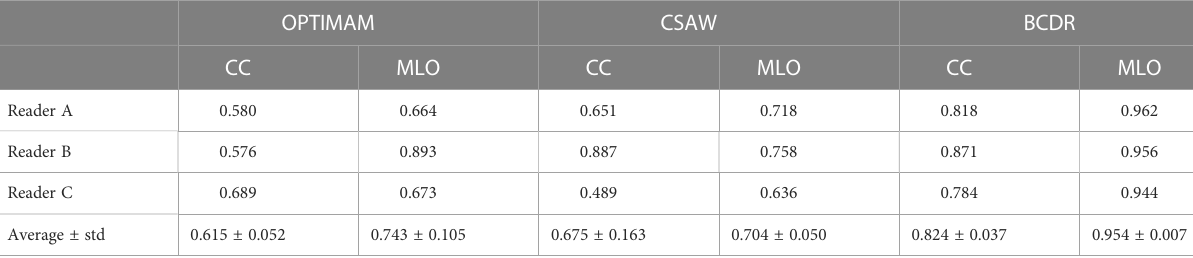
TABLE 5 Reader test results: Area Under the Curve (AUC) from the Receiver Operating Characteristics (ROC) curve of each CycleGAN model and view (CC, MLO).